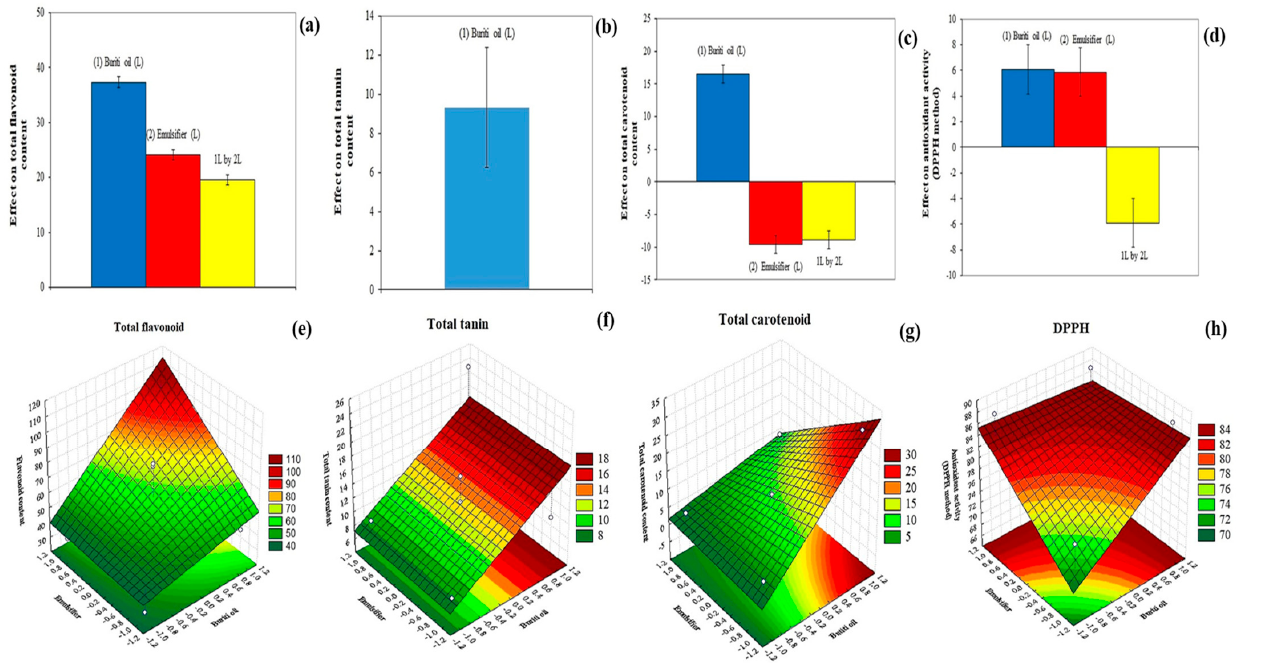
Figure 4. Effect of buriti oil and emulsifier (Tween 20) on total flavonoid content ( a ), total tannin content ( b ), total carotenoid content ( c ), and antioxidant activity (by DPPH method) ( d ) of the cassava-starch-based films. Response surfaces showing the influence of buriti oil and emulsifier on total flavonoid content ( e ), total tannin content ( f ), total carotenoid content ( g ), and antioxidant activity (by DPPH method) ( h ) of films.